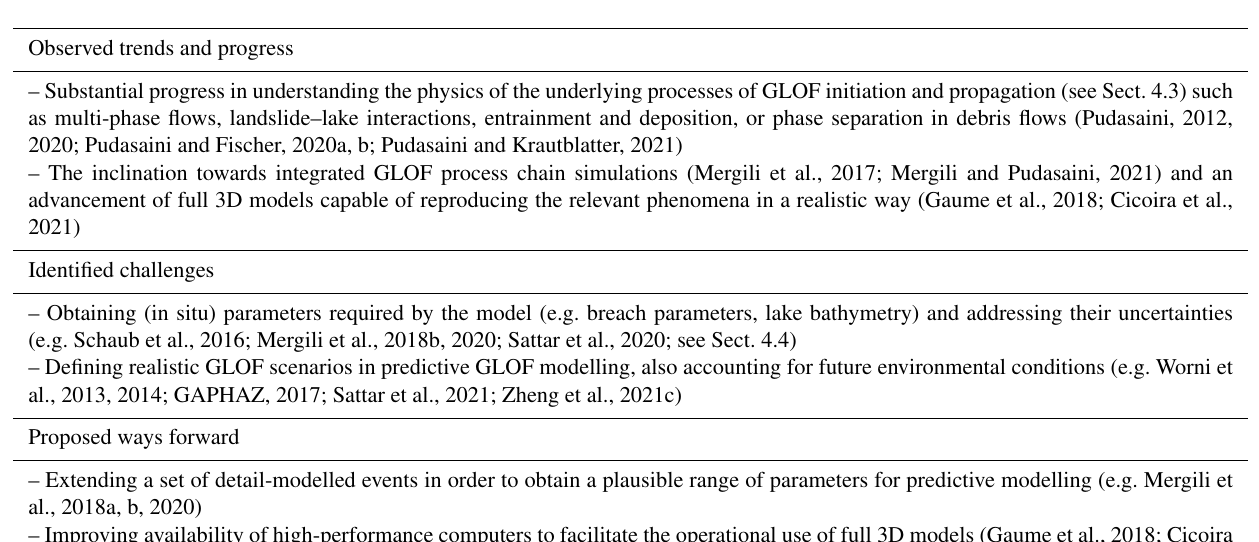
Table 3. Summary of the key topics, observed trends, identified challenges and proposed ways forward in the thematic area modelling GLOFs and GLOF process